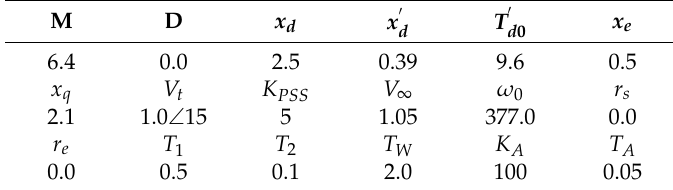
Table 1. The parameters of the single-machine-infinite-bus power system